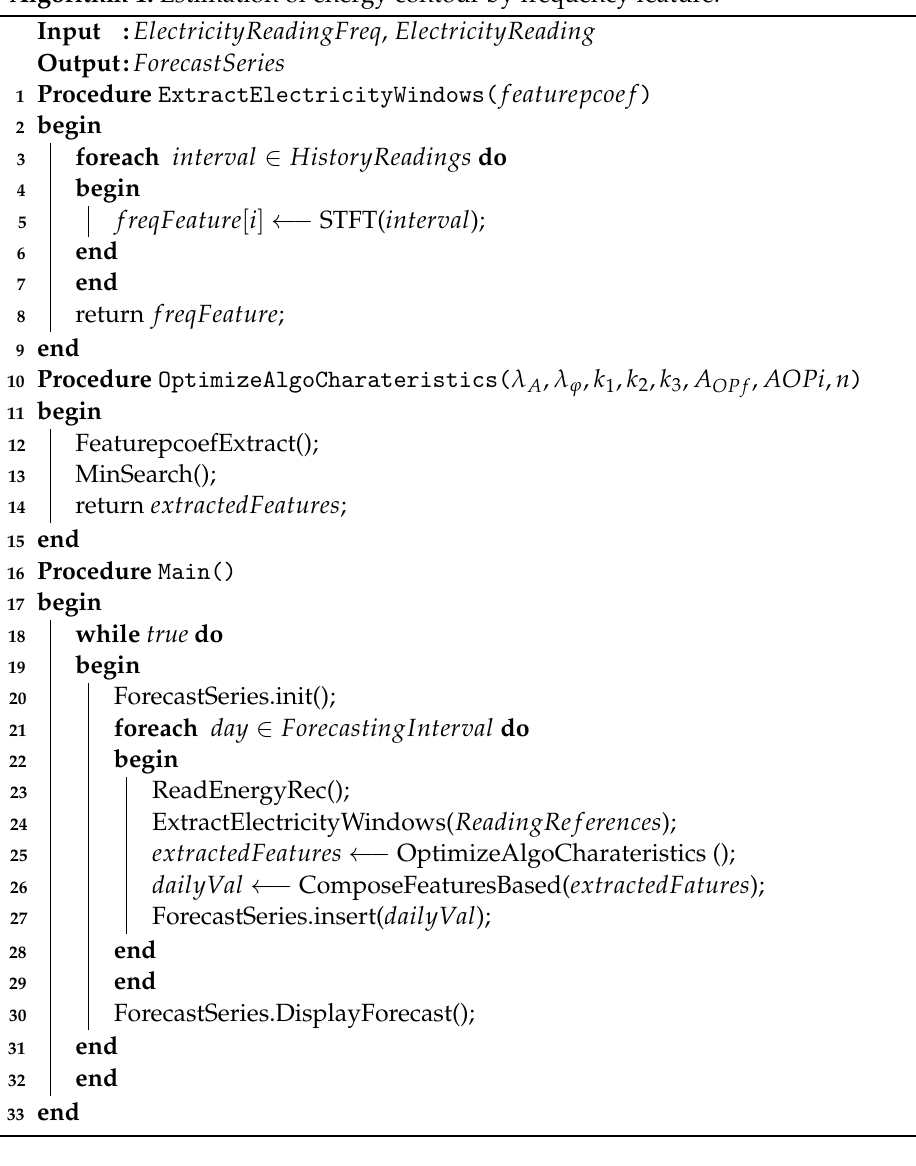
Algorithm 1: Estimation of energy contour by frequency